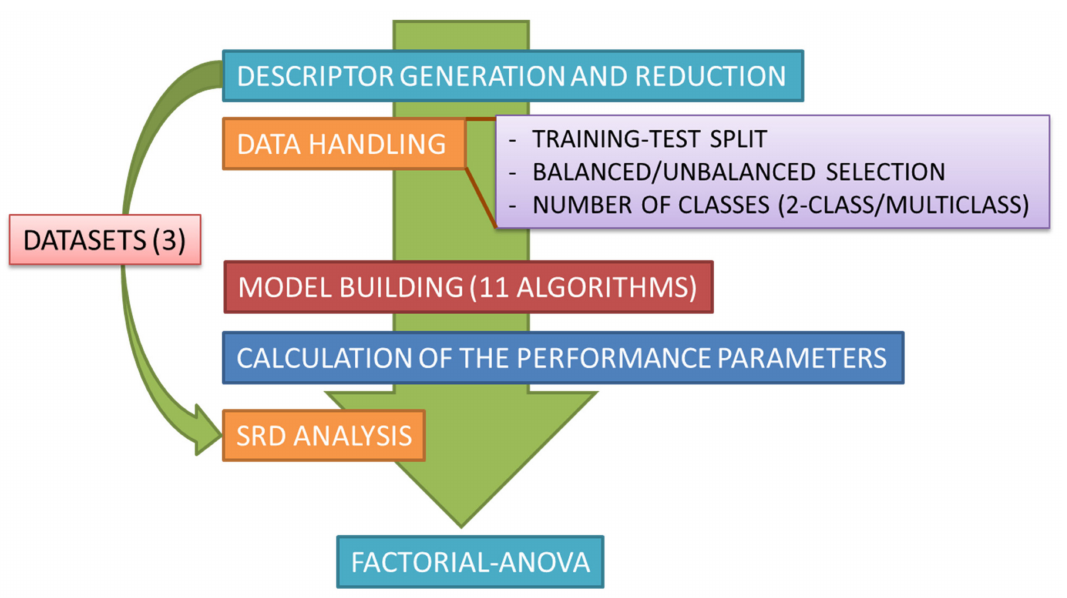
Figure 1. Workflow of the comparative study. Briefly, after descriptor generation and reduction, eleven machine learning methods are applied for model building (for each combination of 2-class / multiclass and balanced / imbalanced cases). After the calculation of the performance parameters, statistical analysis of the results is carried out with sum of ranking di ff erences (SRD) and factorial analysis of variance (ANOVA). The complete process is carried out on three